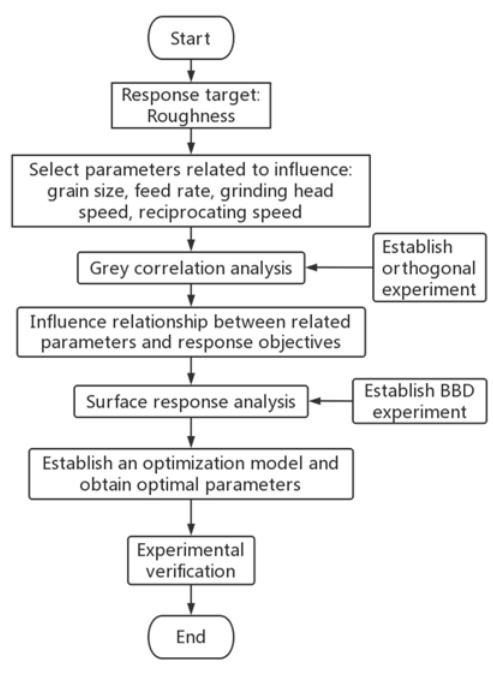
Figure 5. The optimization process